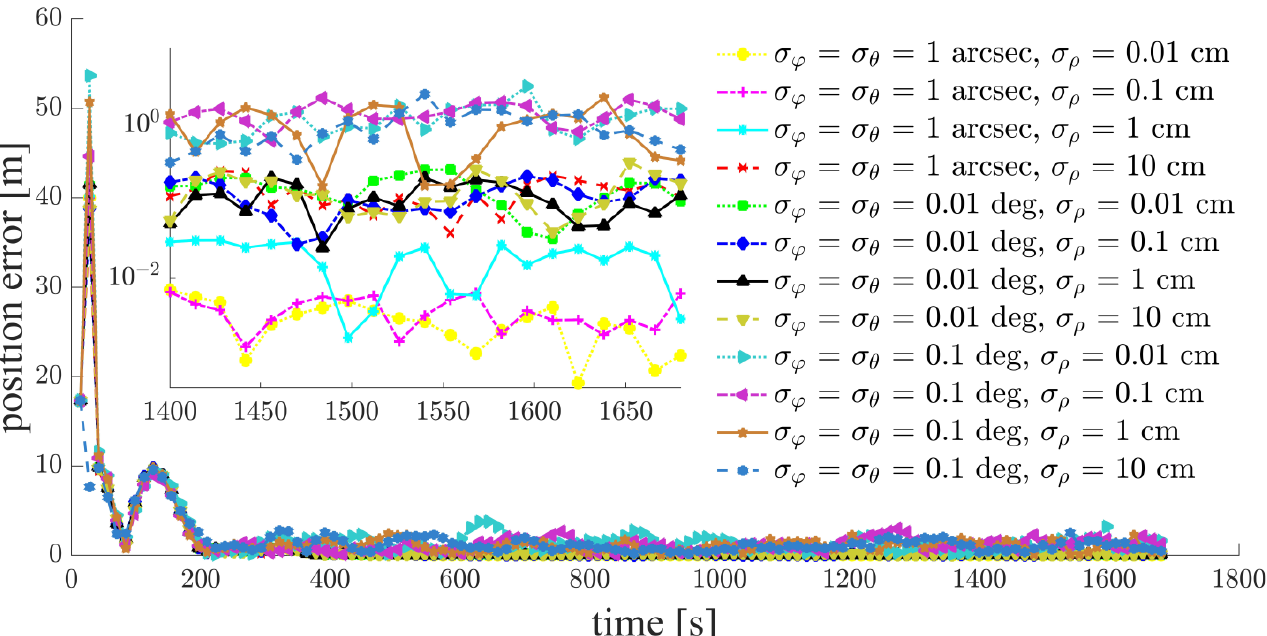
Figure 12. Relative navigation errors of 𝑆 2 (simulated scenario: Case d, space-circle formation radius of 1 km).